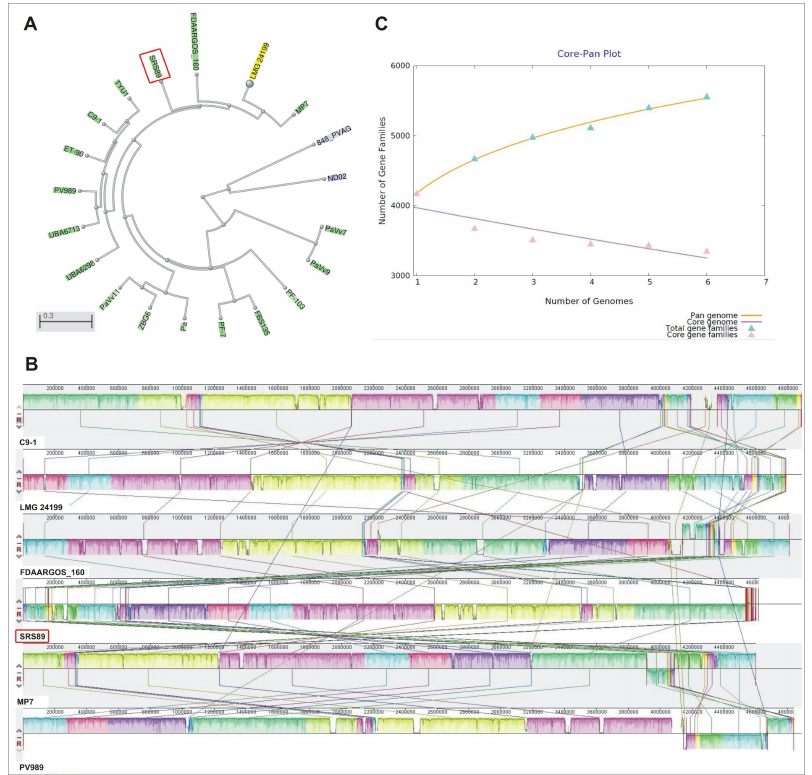
Figure 2. Dendrogram created based on genomic BLAST analysis for all Pantoea vagans strains currently (December 2022) present in the NCBI database ( A ). Genome alignment of selected P. vagans strains using Mauve software (http://darlinglab.org/mauve/user-guide/viewer.html, accessed on 10 January 2023) ( B ). Pan-/Core-genome plot for the six compared P. vagans strains ( C ). Table 2. Genome and genes statistics for the analyzed strains of P. vagans .